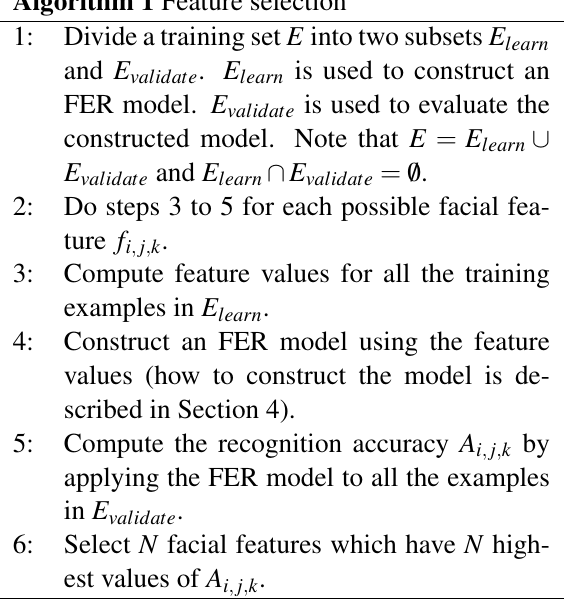
Algorithm 1 Feature